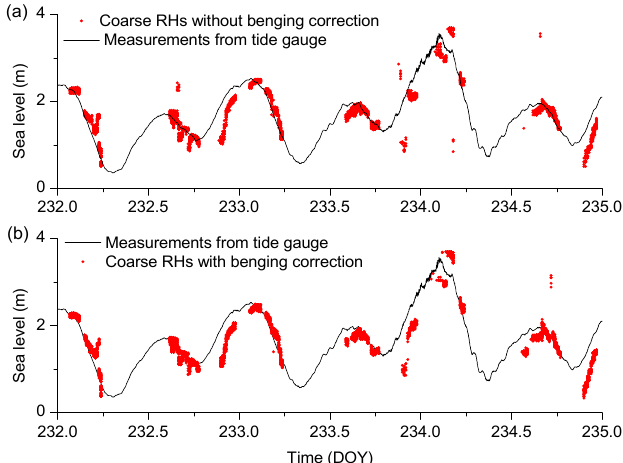
Figure 6. SNR arc, the corresponding wavelet spectrogram, and the corresponding peak RH series with and without elevation bending correction: ( a ) the SNR arc with bending uncorrected elevation of GPS L2C from PRN 3 satellite on DOY 237, 2017; ( b ) the SNR arc with bending corrected elevation of GPS L2C from PRN 3 satellite on DOY 237, 2017; ( c ) the wavelet spectrogram of SNR arc in ( a ); ( d ) the wavelet spectrogram of SNR arc in ( b ); ( e ) the peak RH series of ( c ); ( f ) the peak RH series of ( d ); ( g ) the peak RH series of ( c ) with RH in range of 7.2 m to 7.8 m; ( h ) the peak RH series of ( d ) with RH in range of 7.2 m to 7.8 m.